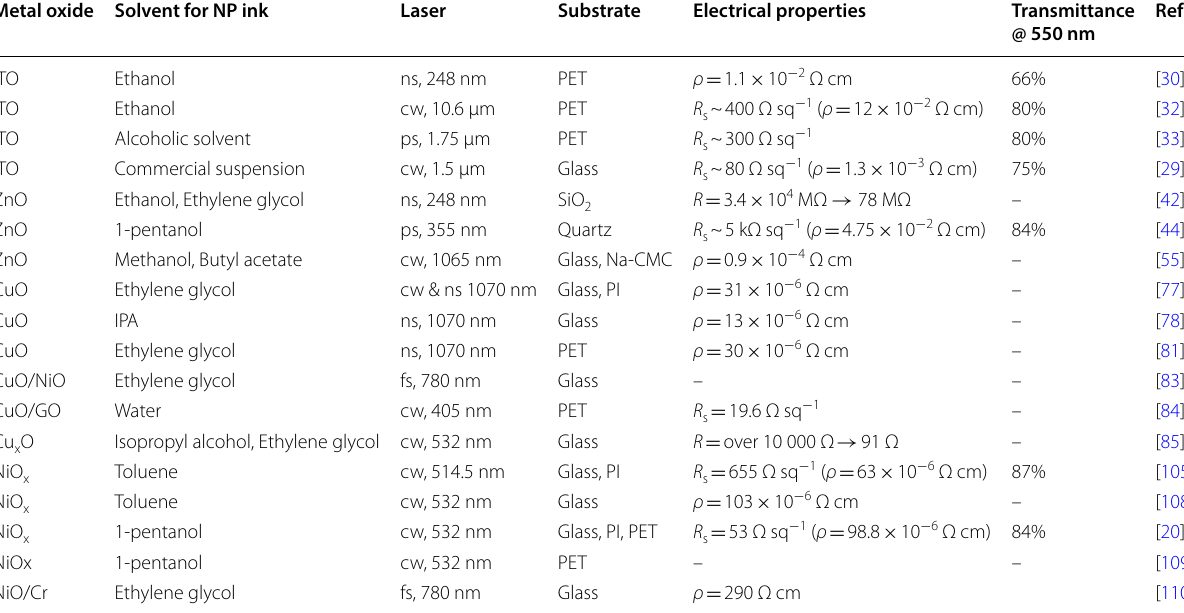
Table 1 Summary of studies on the laser digital patterning process using metal oxide nanomaterials Metal oxide Solvent for NP ink